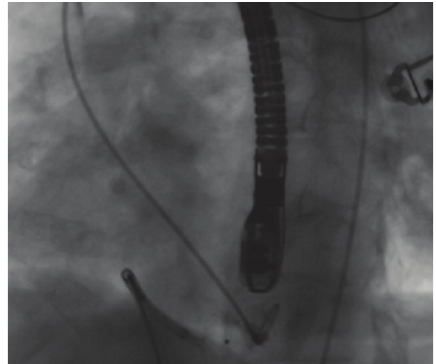
Figure 4: Percutaneous transcatheter Amplatzer occluder device inserted across apical ventricular septal